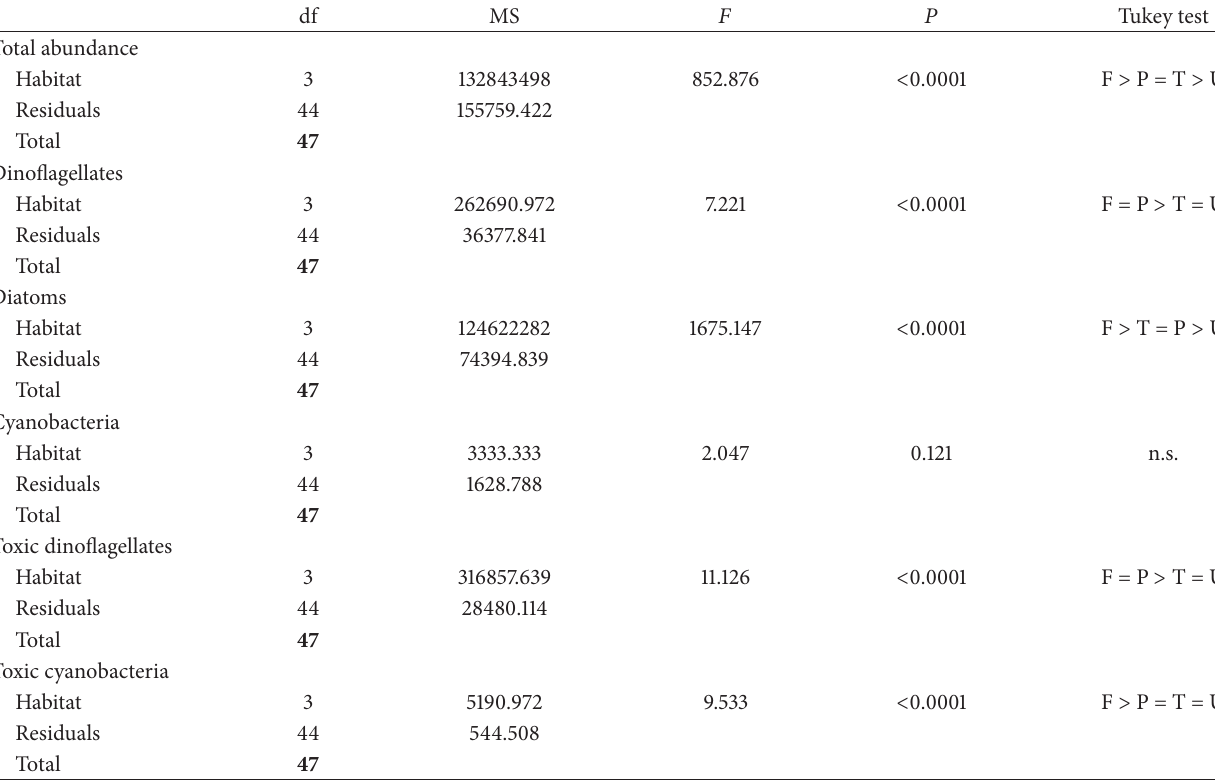
Table 2: Analysis of variance ANOVA of the abundances of major groups of microalgae and cyanobacteria in prospected stations.